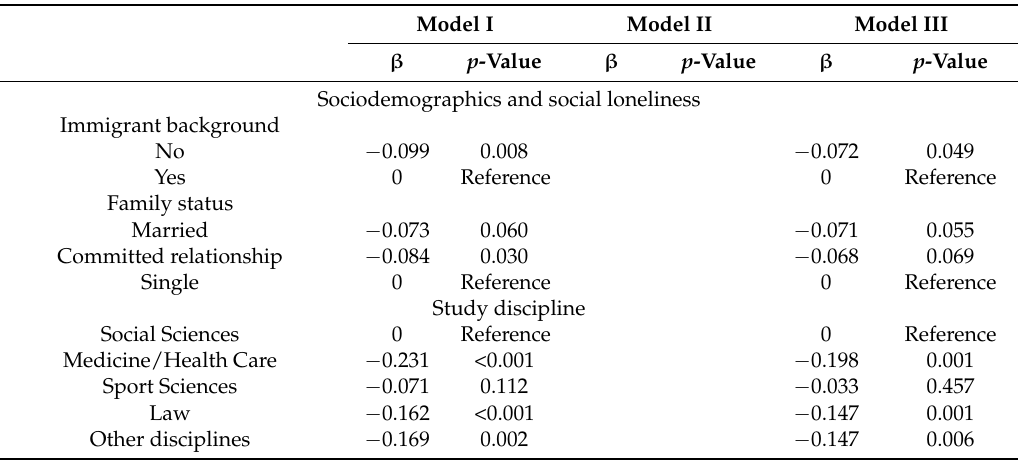
Table 5. Regression on social loneliness in university students in